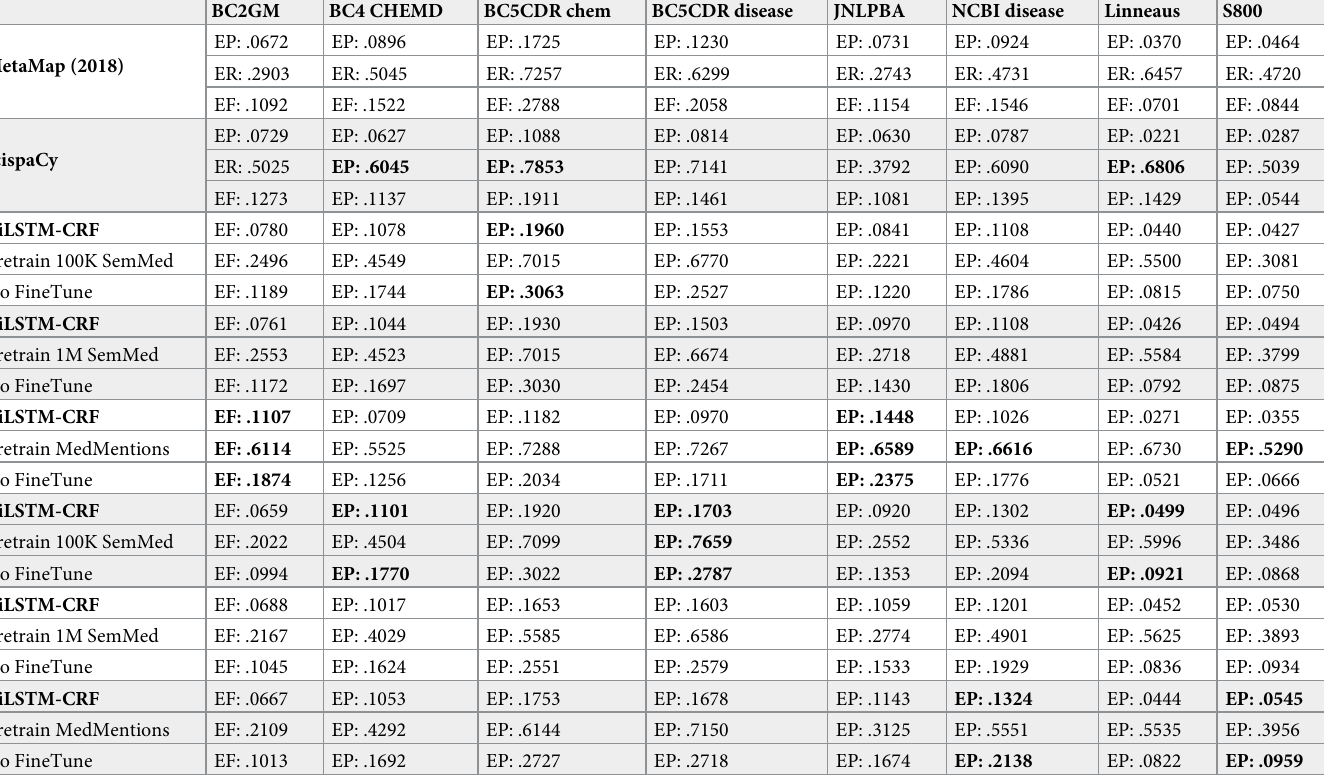
Table 4. Exact precision, recall, and F1 score of the BiLSTM-CRF and BlueBERT on each of our target datasets when pre-trained on different corpora without fine- tuning. BC2GM BC4 CHEMD BC5CDR chem BC5CDR